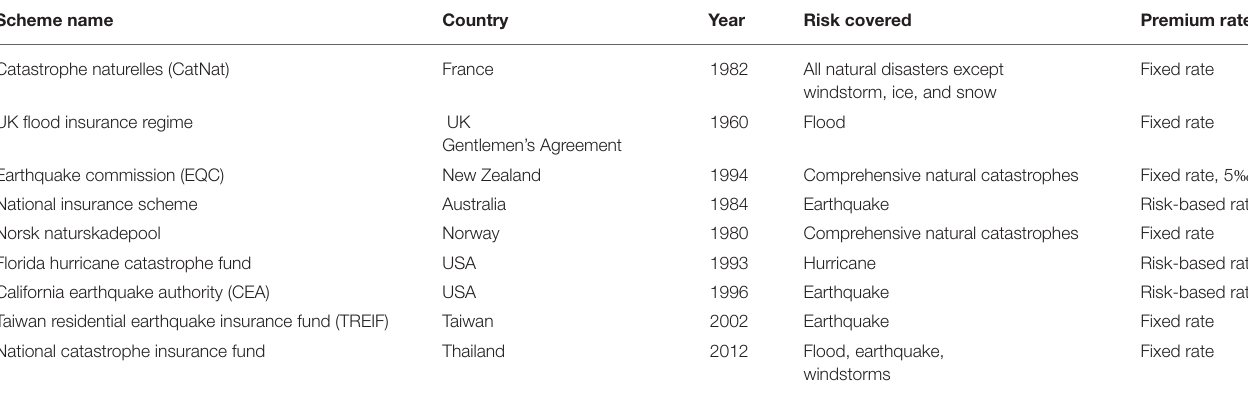
TABLE 2 | Comparison of typical natural catastrophe insurance schemes.